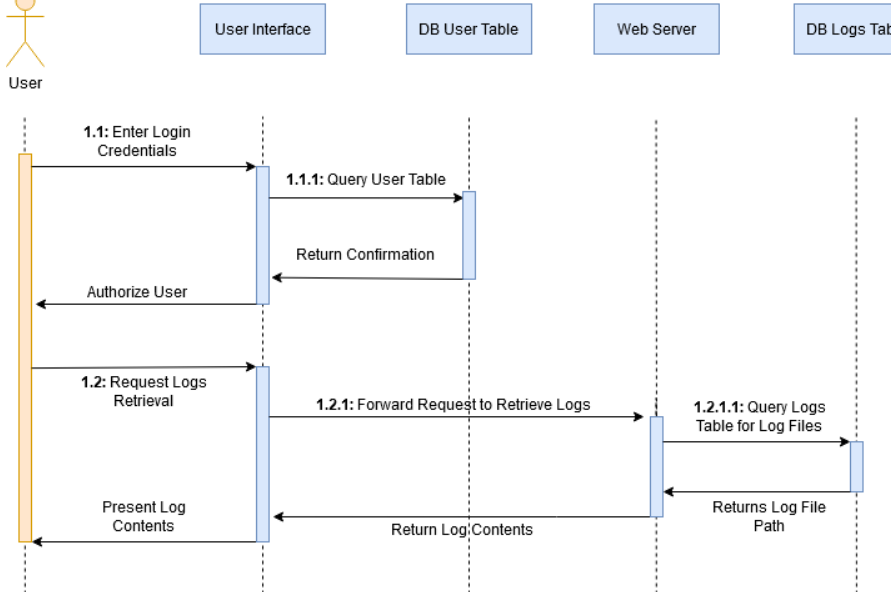
Figure 2. Log Retrieval Sequence